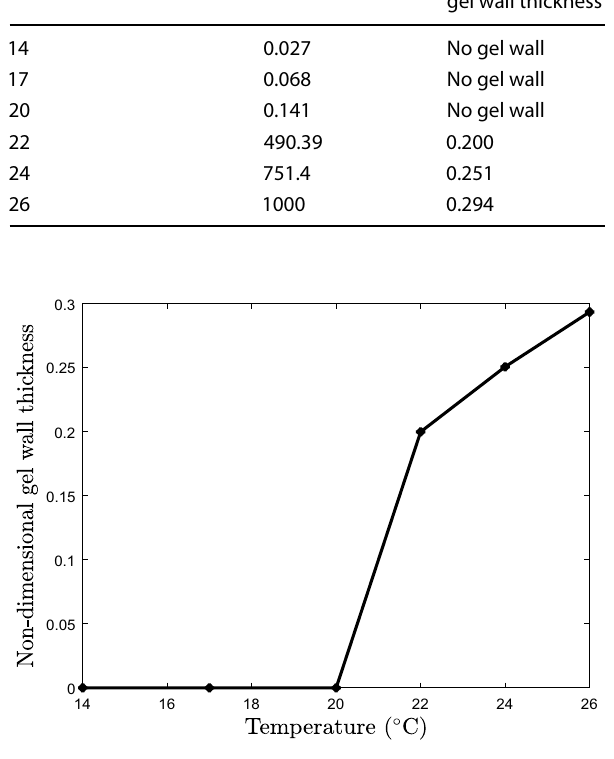
Fig. 13 Changes in gel wall thickness as a function of